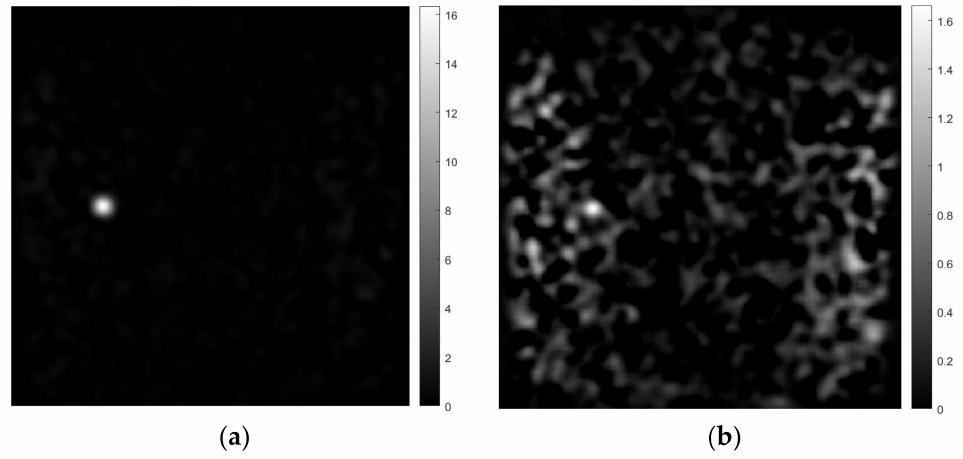
Figure 14. Results (720 × 720) of the pencil beam spot scanning method. 5 mg/mL: ( a ); 0.5 mg/mL: ( b ).